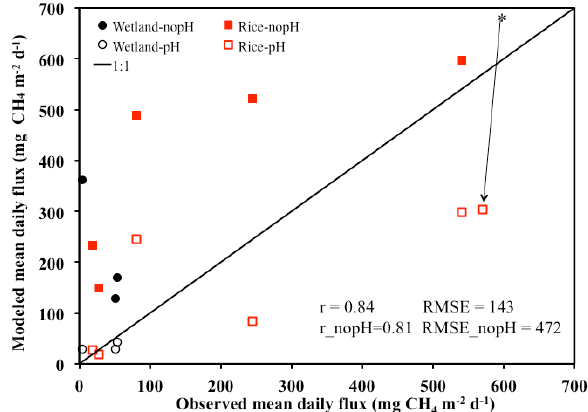
Fig. C1. Scatter plot of modeled mean daily flux with (and without ) pH function with observations. * indicates the corresponding modeled mean daily flux without pH function at this site is 1601 mg CH 4 m -2 d -1 which is beyond the range and not shown in this figure. Because of the limited wetland sites (only 3), we used both wetland and rice paddy sites together to calculate the correlations and RMSE. A detailed analysis of these three wetland sites is provided in section 4.3.